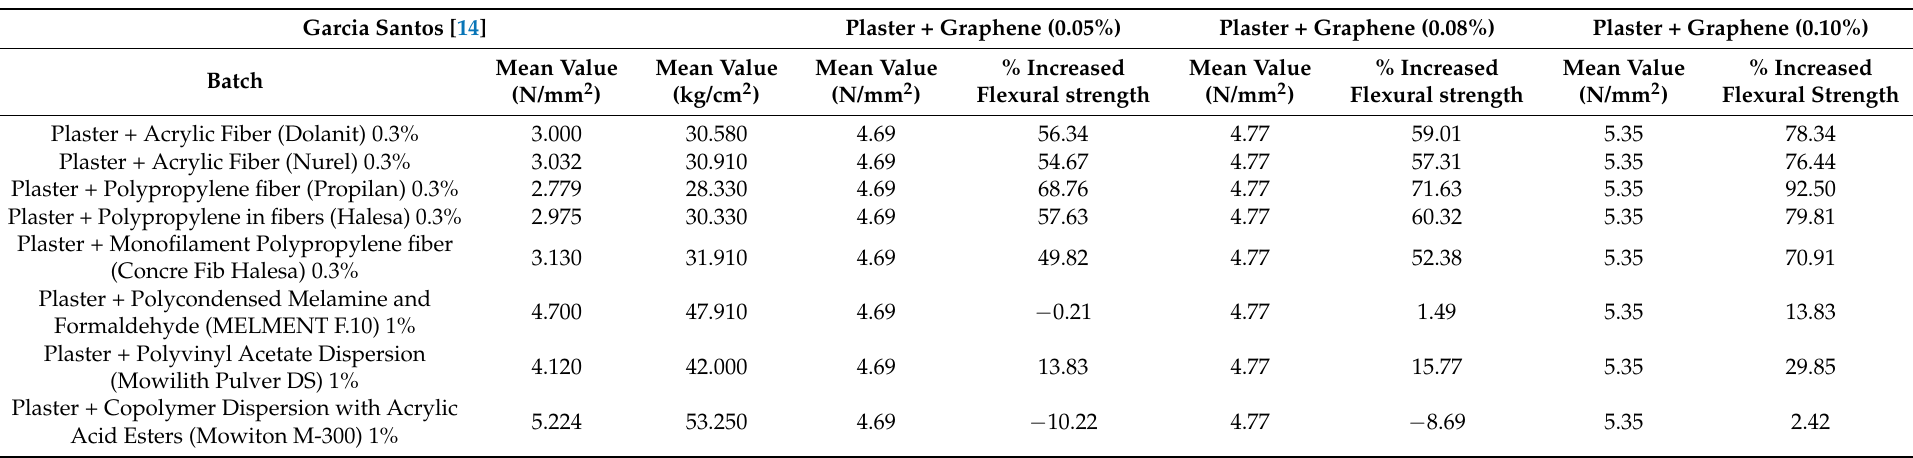
Table 9. Comparison of bending strength test results of gypsum mortar with added graphene powder with those in [14]. Garcia Santos [14] Plaster + Graphene